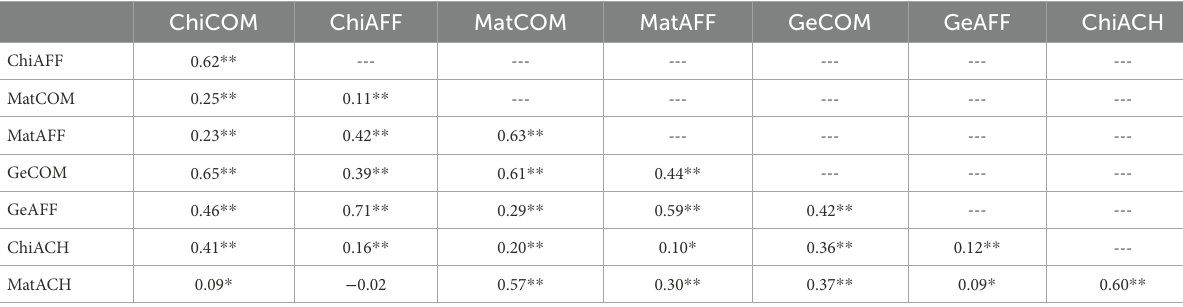
TABLE 5 Factor correlations at